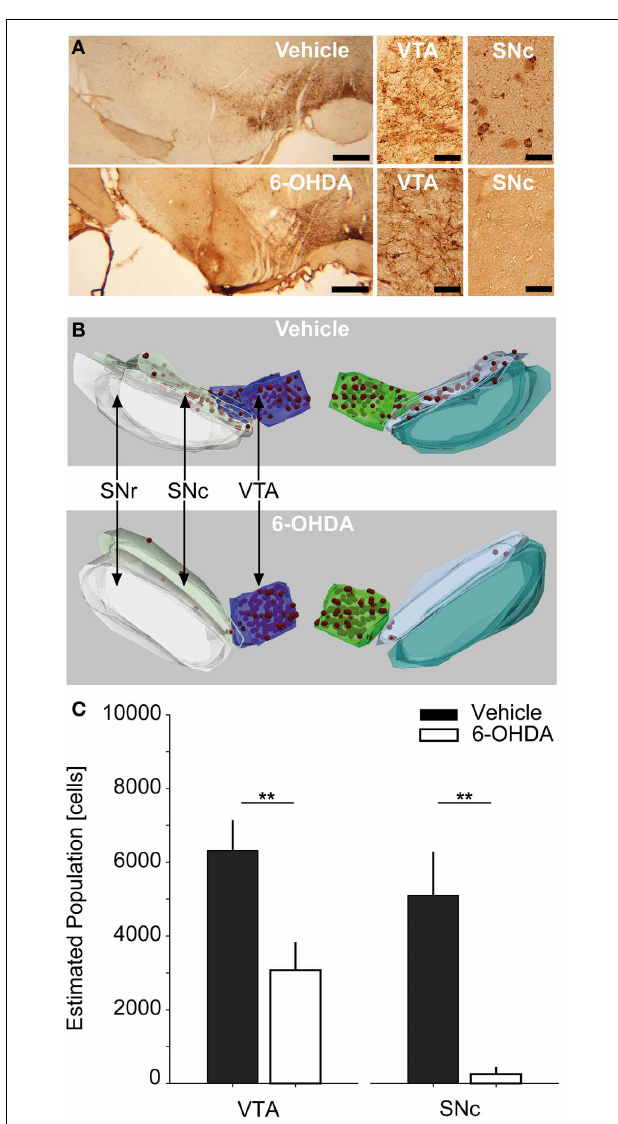
FIGURE 1 | Stereological counting of TH-positive SNc and VTA neurons. (A) Representative photomicrographs of TH-stained midbrain sections of a vehicle and 6-OHDA injected rat (left column, scale bar equals 500 µ m) as well as 40 × magnifications of VTA and SNc-ROIs (middle and right column, scale bar equals 50 µ m). (B) 3D-reconstructions of stereological regions of interest for the same vehicle and 6-OHDA injected rats as in (A) . Red spheres indicate stereologically counted cells in the SNc and VTA. (C) Estimated absolute population of cells in the SNc and VTA for vehicle ( n = 5) and 6-OHDA ( n = 8) injected rats. Double asterisks denote P ≤ 0 . 001 (uncorrected). TH, tyrosine-hydroxylase; 6-OHDA, 6-hydroxydopamine; VTA, ventral tegmental area; SNc, substantia nigra pars compacta; SNr, substantia nigra pars